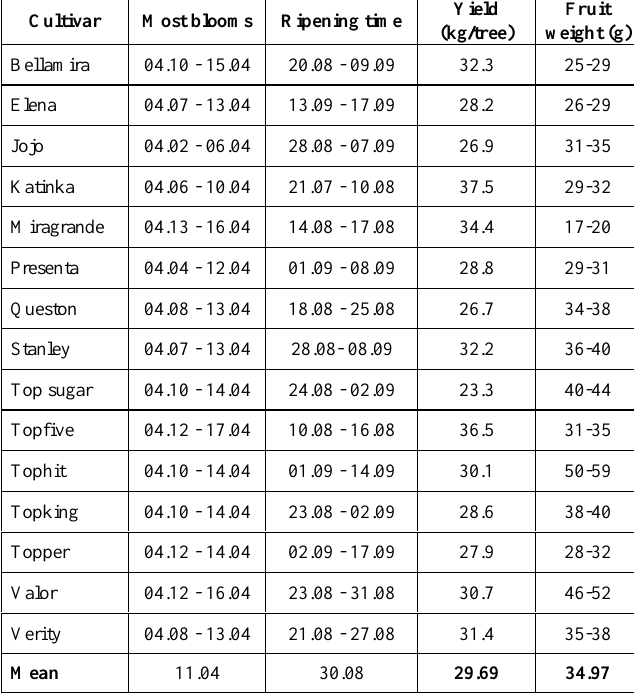
Table 3. Pomological valuabilty of introduced plums